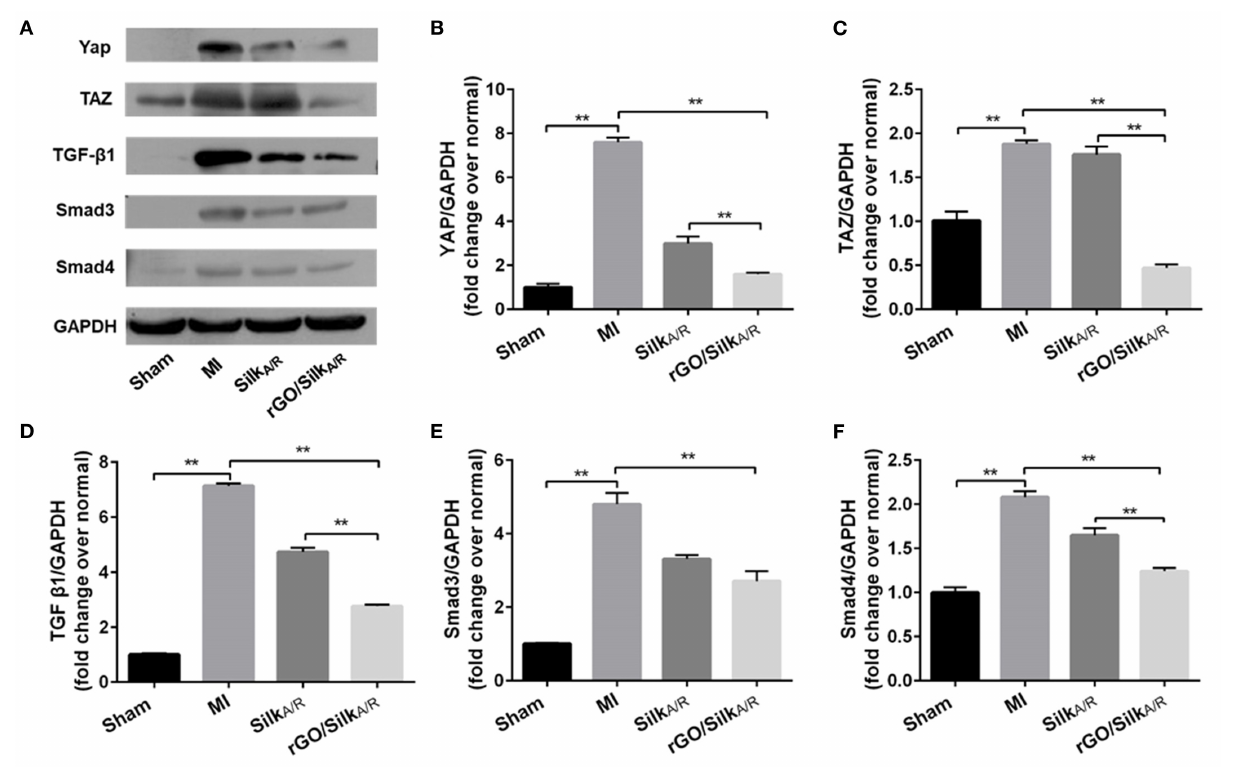
FIGURE 4 | Western blot analysis of the expression of YAP/TAZ and canonical TGF- β 1/Smads signaling pathway in infarcted region. Myocardial fibrosis (YAP, TAZ, TGF-b1, Smad3 and Smad4) in rat myocardium was examined at 28 days’ post-surgery. Data are mean ± SEM from three independent experiments. Data are mean ± SEM from three independent experiments. ** P <